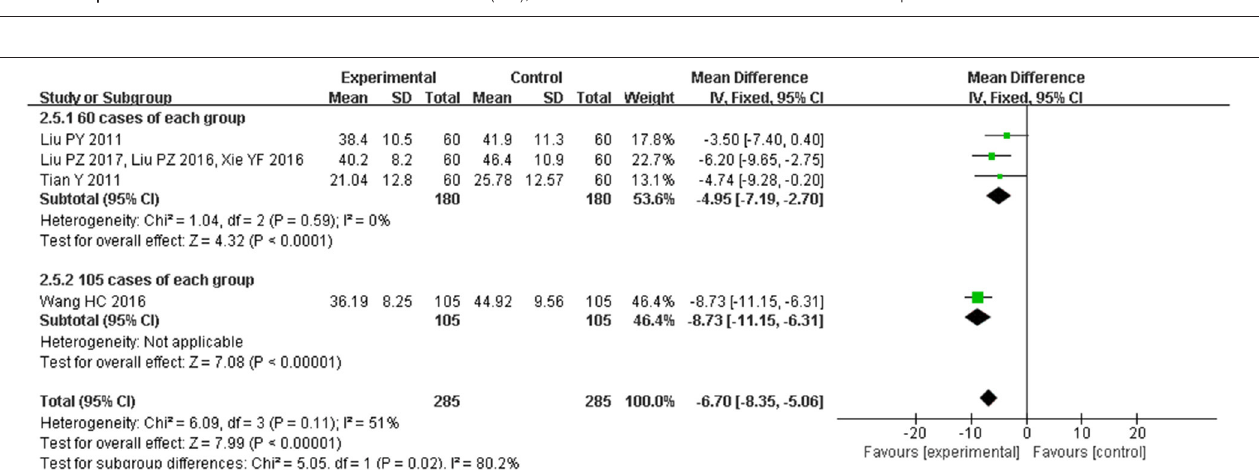
FIGURE 4 | Pooled and individual estimates of mean difference (MD), and 95% CI of 6MWD for CHM and control therapies.